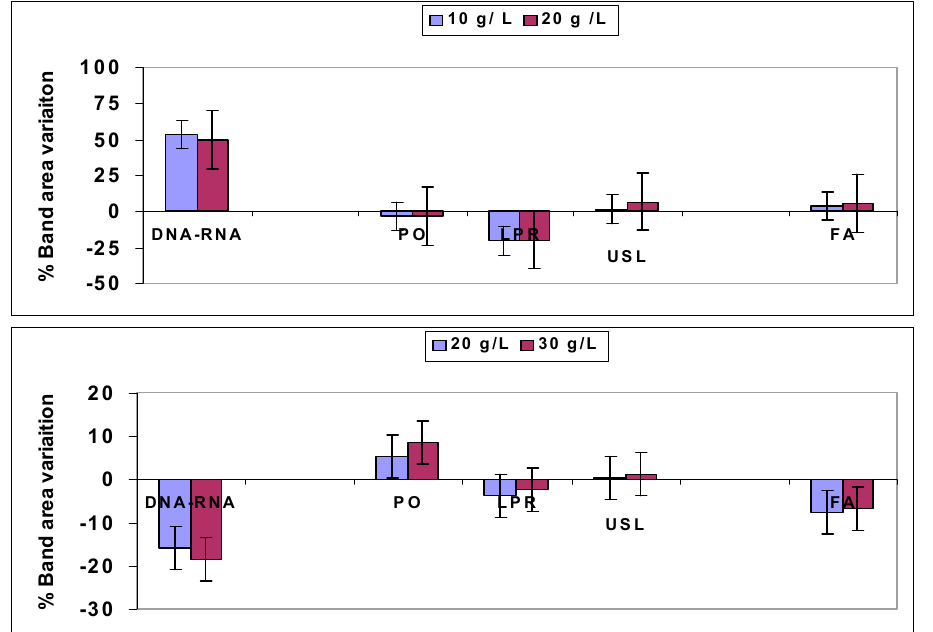
Figure 6. Bar charts of the band area variation with respect to the control sample observed in the FTIR spectra for the As exposure of the June (upper) and July (bottom) plots. Here, the results are the average of the three replicated spectra for each As exposure.